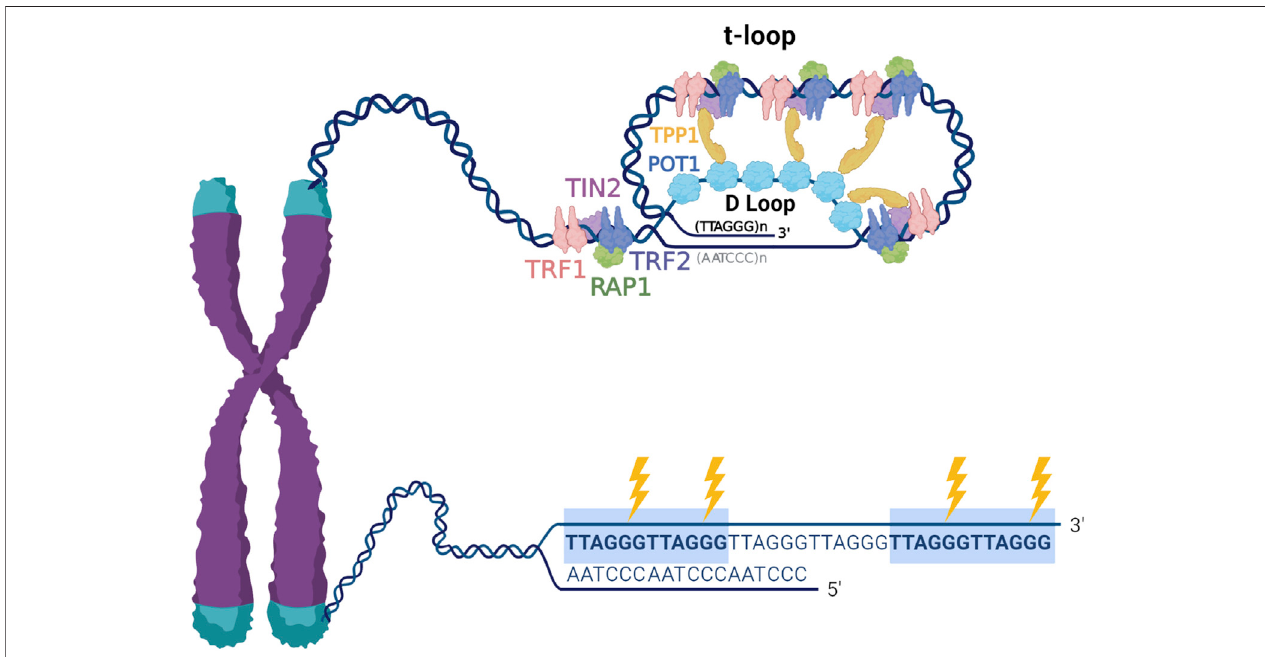
FIGURE 1 | Telomere structure and sensitivity to oxidative damage. Telomeres are nucleoprotein structures composed of repetitive TTAGGG sequence and associatedtelomere-speci fi cproteins,namedshelterin.TelomericDNAterminatesina3 ′ singlestrandedoverhang,whichinvadesthedoublestrandedtelomericDNAto form a lariat-like t-loop. The formation of the t-loop is mediated by the protective shelterin complex, which consists of TRF1, TRF2, RAP1, TIN2, TPP1 and POT1. The highly repetitive G-rich telomeric repeats are preferred sites for production 8-oxoG (indicated by the lightning bolts), therefore, telomeric DNA is remarkably susceptible to oxidative